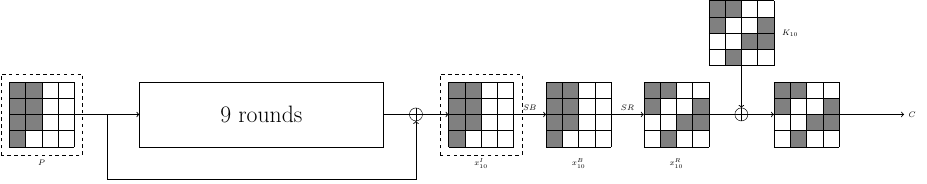
Figure 19: Key-recovery attack for Dual-AES-PRF 9 , 1 .